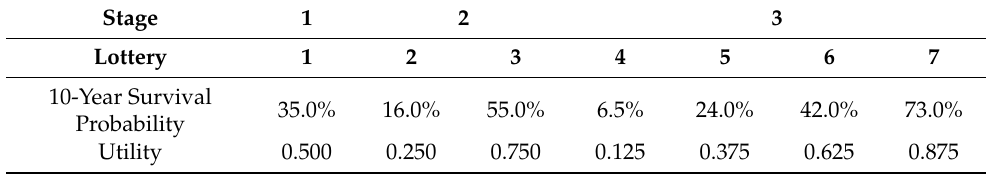
Table 1. Average results of the interviews based on SG technique. SG, standard gamble.